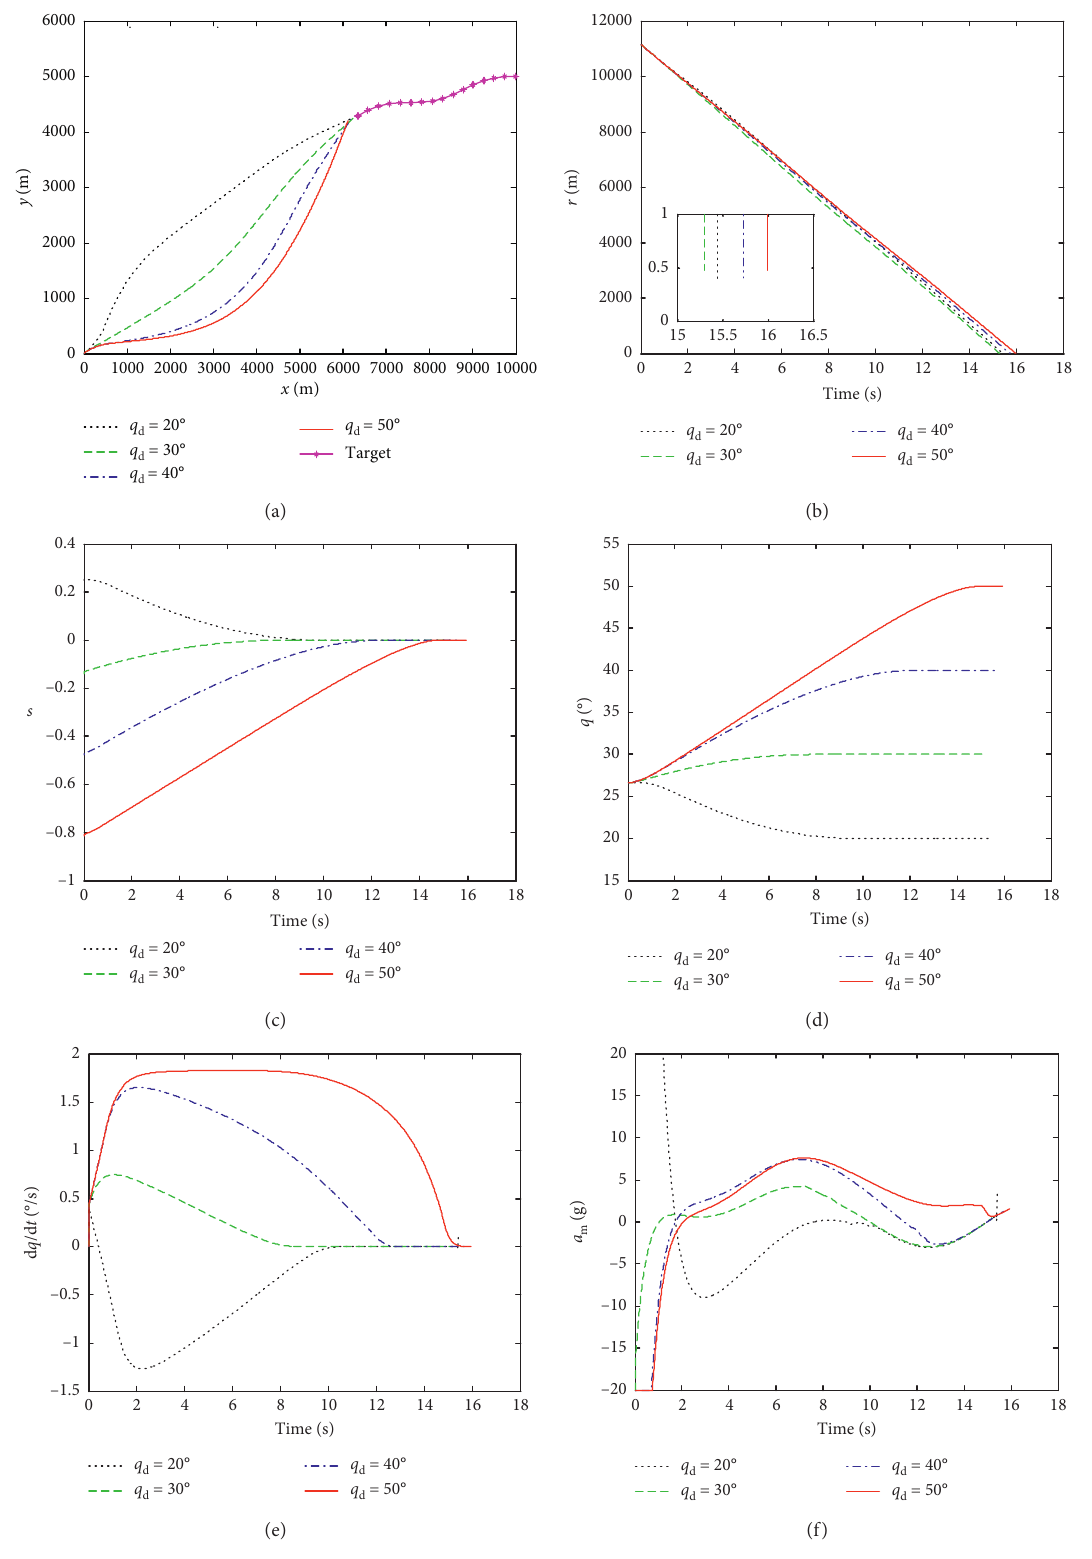
Figure 2: Simulation results of Case 1. (a) Missile and target motion trajectory. (b) Relative distance between the missile and the target. (c) Sliding mode. (d) LOS angle. (e) LOS angular rate. (f) Missile